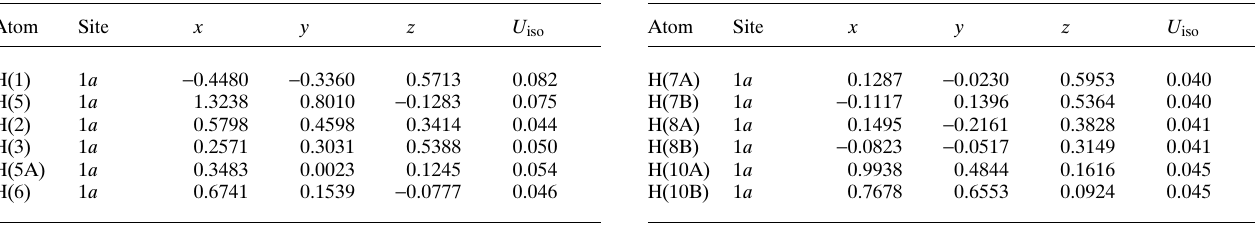
Table 2. Atomic coordinates and displacement parameters (in Å 2 )